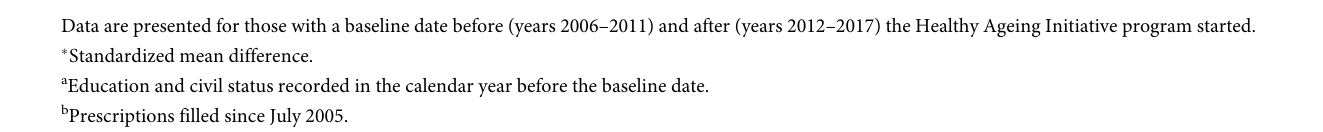
measurements of LDL-cholesterol were obtained in 2,347 individuals from the HAI cohort. As was the case for blood pressure, LDL-cholesterol levels were reduced depending on the LDL- levels at baseline (Fig 8). For those with LDL-cholesterol levels above 4.11 mmol/l at baseline, a mean reduction of 1.3 mmol/l was seen more than 2 years after the initial measurement. In contrast, LDL-cholesterol did not change in those with LDL-cholesterol < 3.36 mmol/l at baseline.